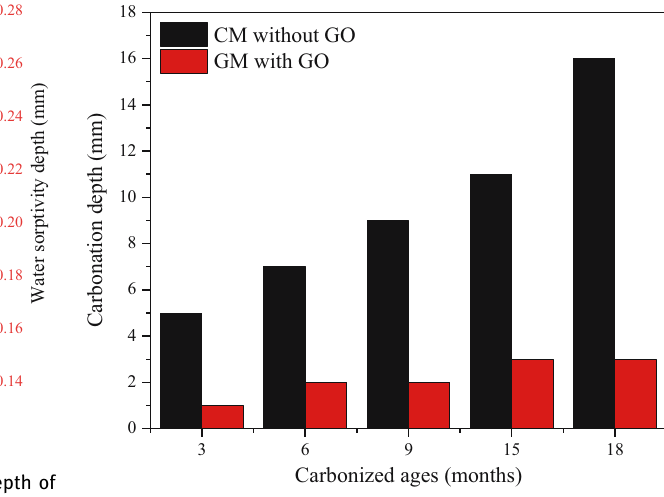
- modi fi ed mortars [ 83 ]